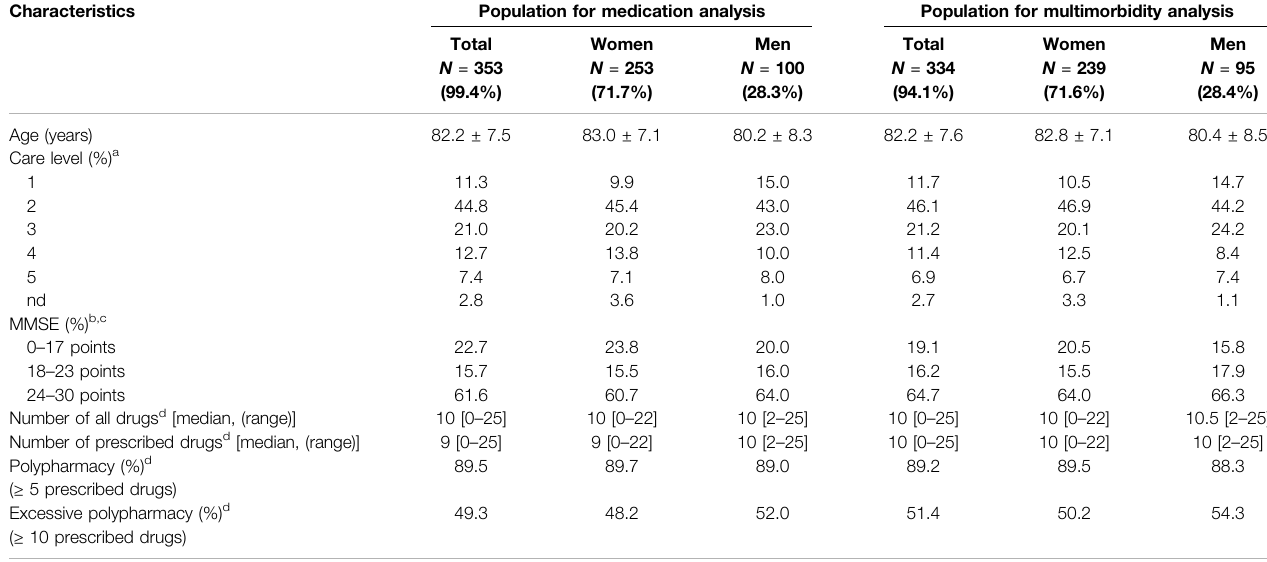
TABLE 1 | Patients ’ characteristics.